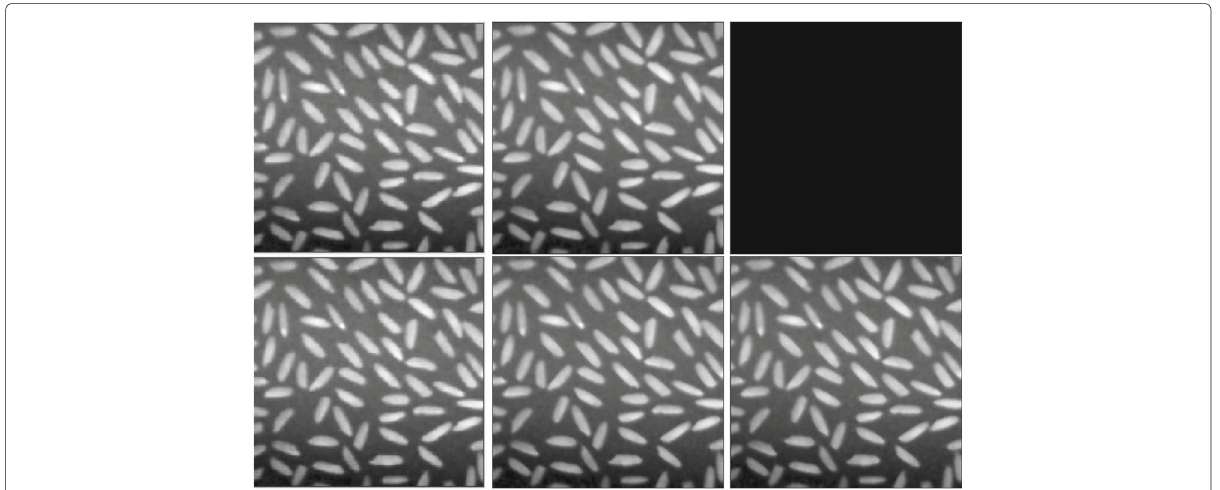
Fig. 10 Toprow , restored Rice image by PMPL method; bottomrow , restored images by our algorithm; first column, noisy images; two right columns, recovered with λ = 29.05 and λ = 29,